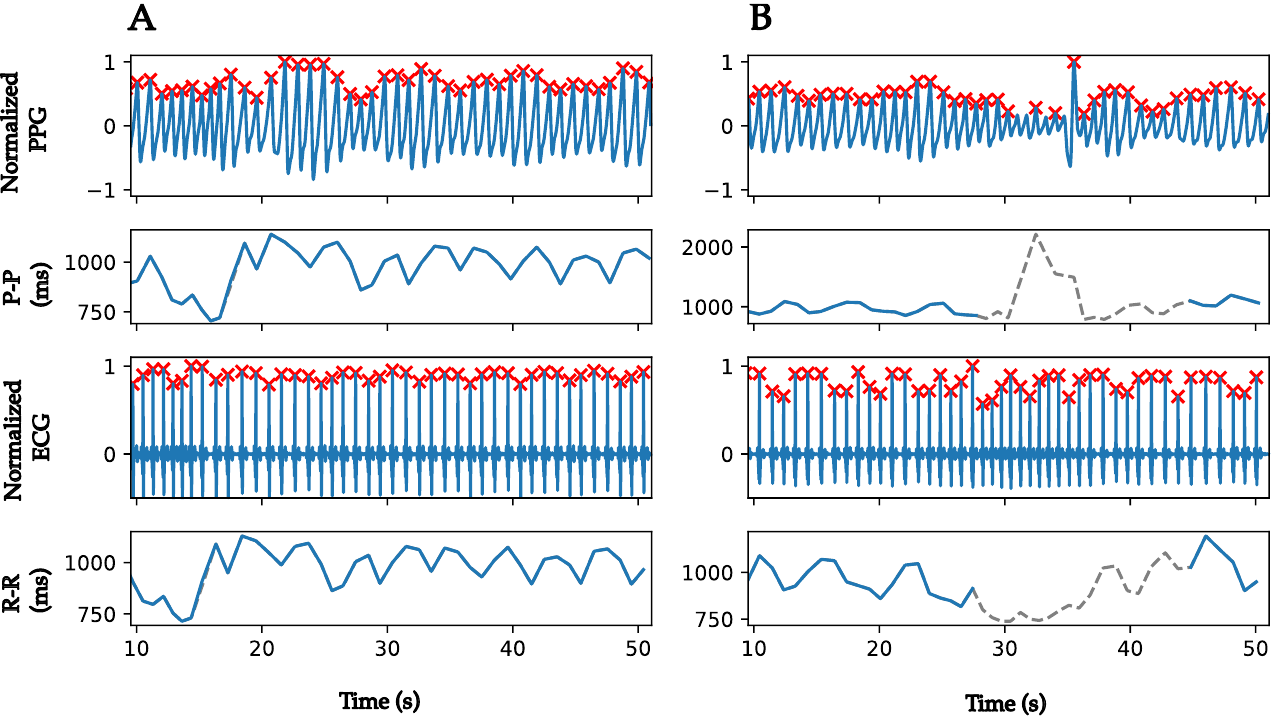
Figure 3. Examples of PPG and ECG recordings with corresponding peaks detection and peak-to- peak intervals. ( A ) Peaks detections from a good-quality PPG recording and an ECG recording. ( B ) Peaks detections and poor-quality periods identification from a noisy PPG recording and an ECG recording. Red cross markers represent the peaks detected. In the P-P and R-R intervals plots, the grey dotted lines present the initial computed P-P and R-R intervals that were eliminated in the correction phase, and the blue plain lines present the NN intervals after correction of outliers, ectopic beats, and removal of poor-quality periods.